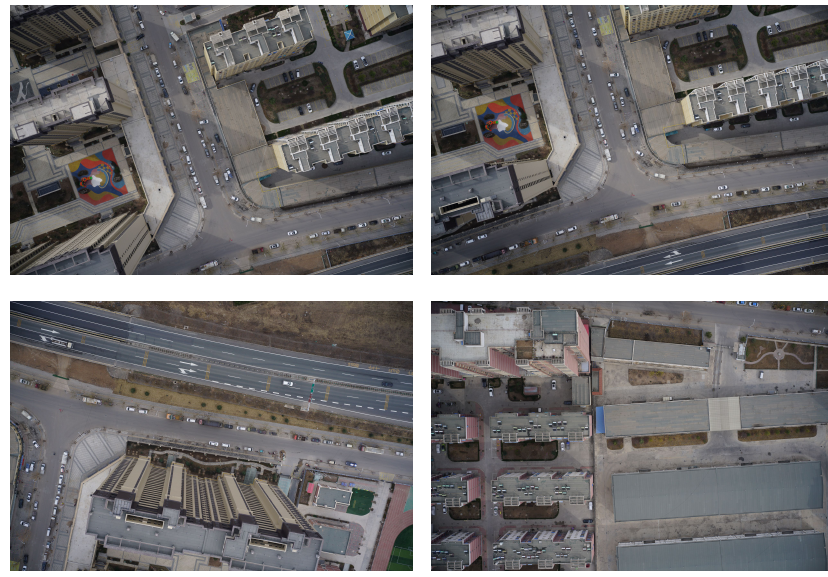
Figure 7. Some of the aerial images were used to generate the digital orthophoto of a city.